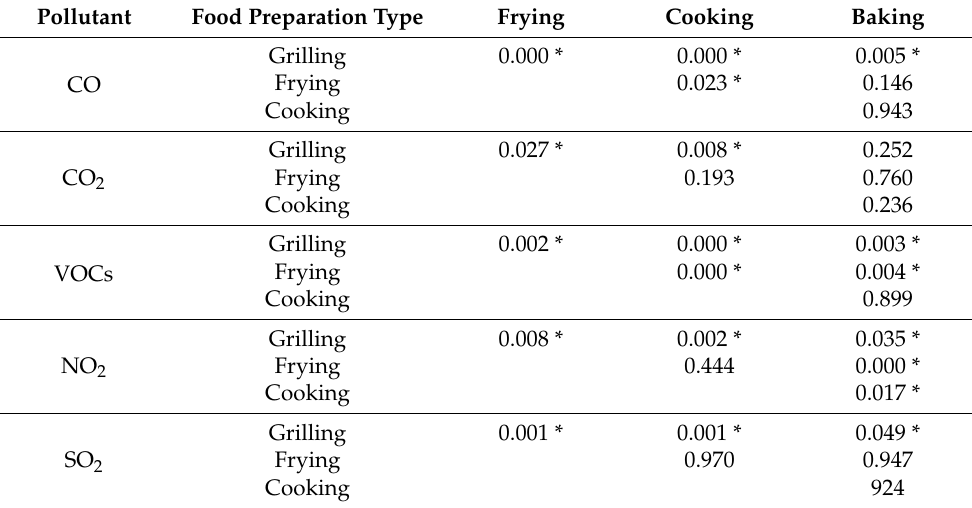
Table 3. Independent t -test for mean levels of pollutants in chimney exhaust. Pollutant Food Preparation